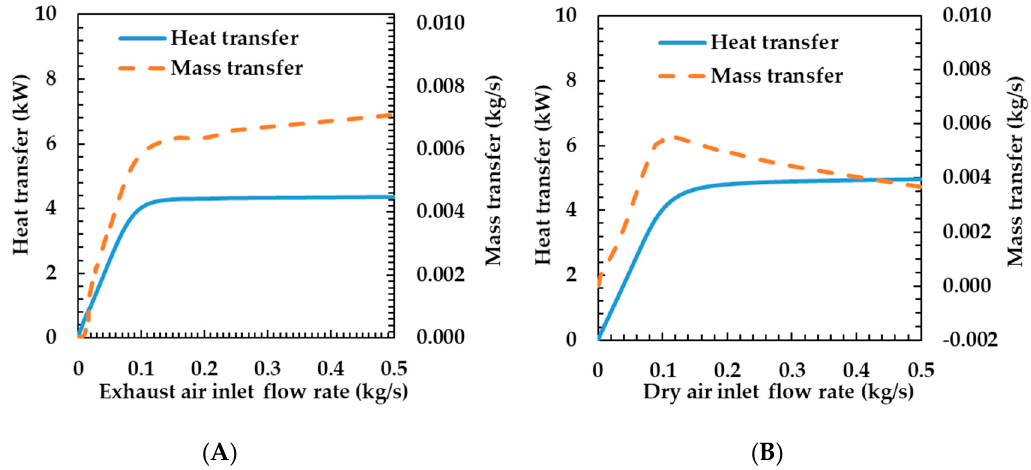
Figure 7. Effects of exhaust air ( A ) and dry air ( B ) inlet flow rate on heat and mass transfer rates of the porous metal foam humidifier.